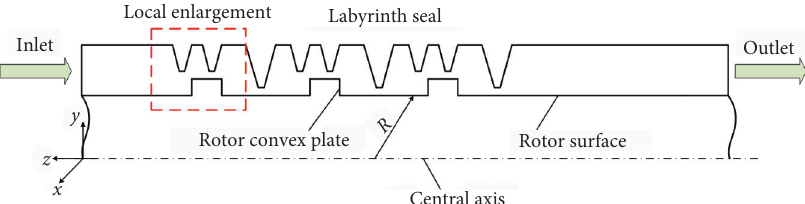
Figure 1: Two-dimensional geometry model of the staggered labyrinth seal (original model).